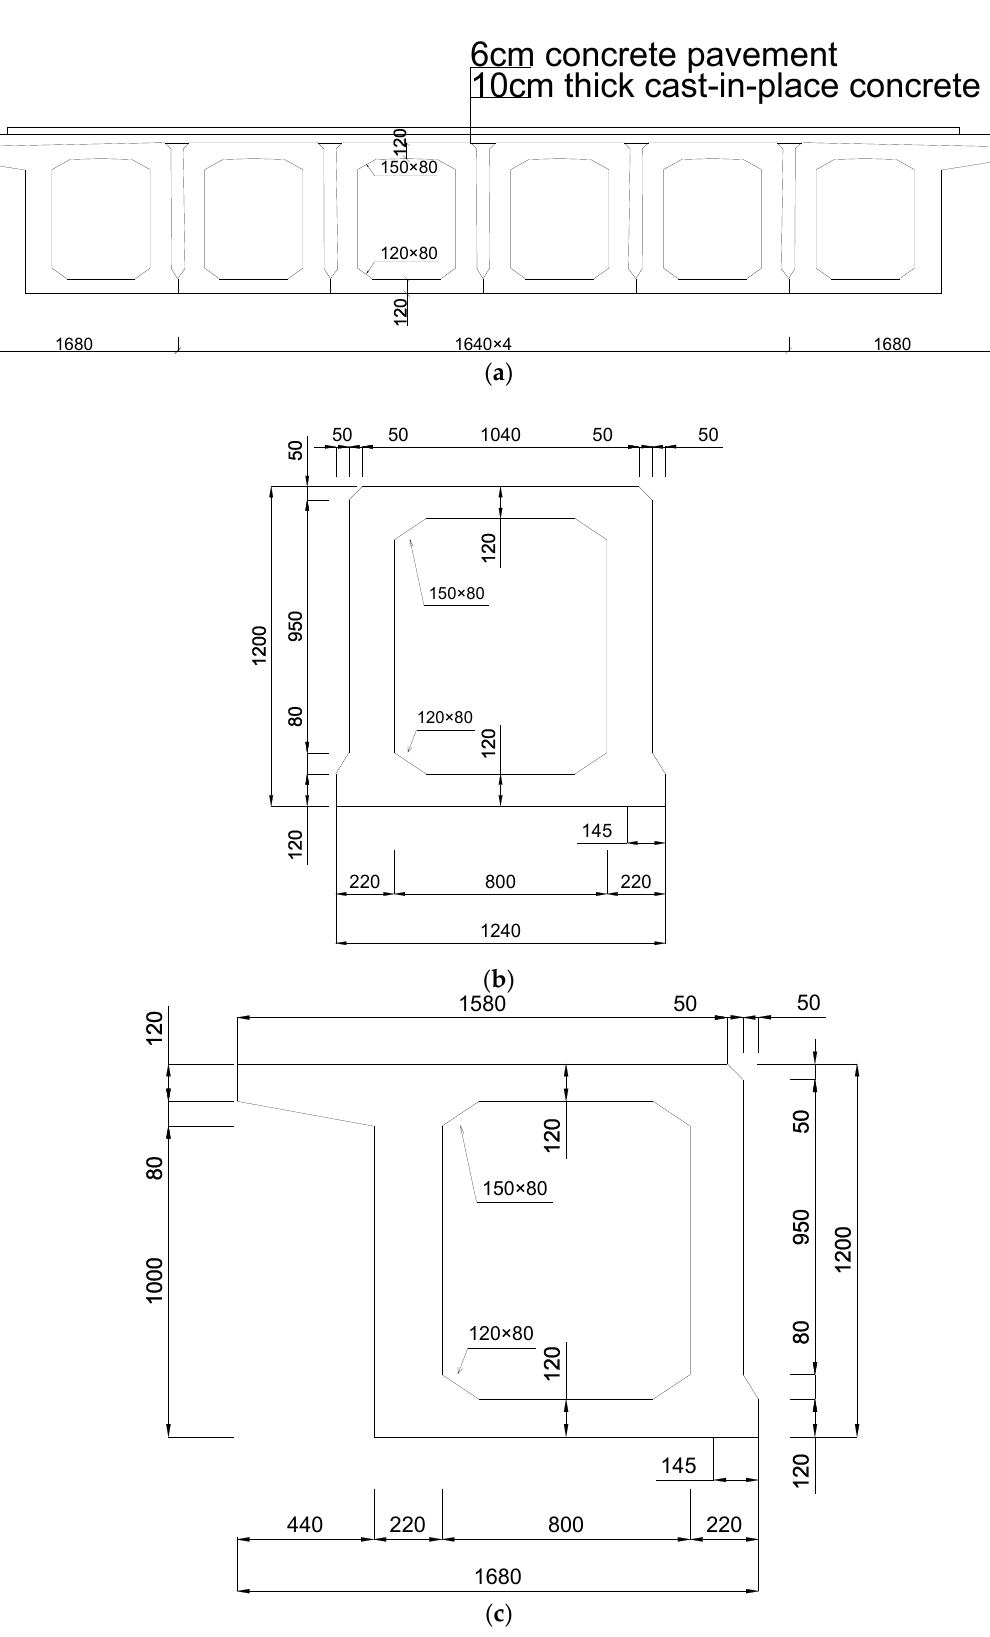
Figure 6. Cross section of the bridge. ( a ) Cross section of the bridge. ( b ) Cross section of the board. ( c ) Cross section of side board.